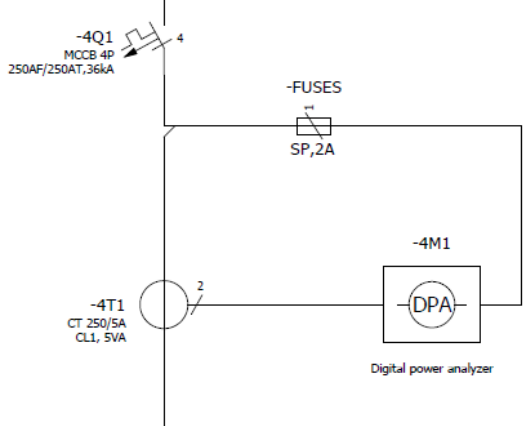
Figure 5: Distribution system for test panel. It consists of 250A rated MCCB for test